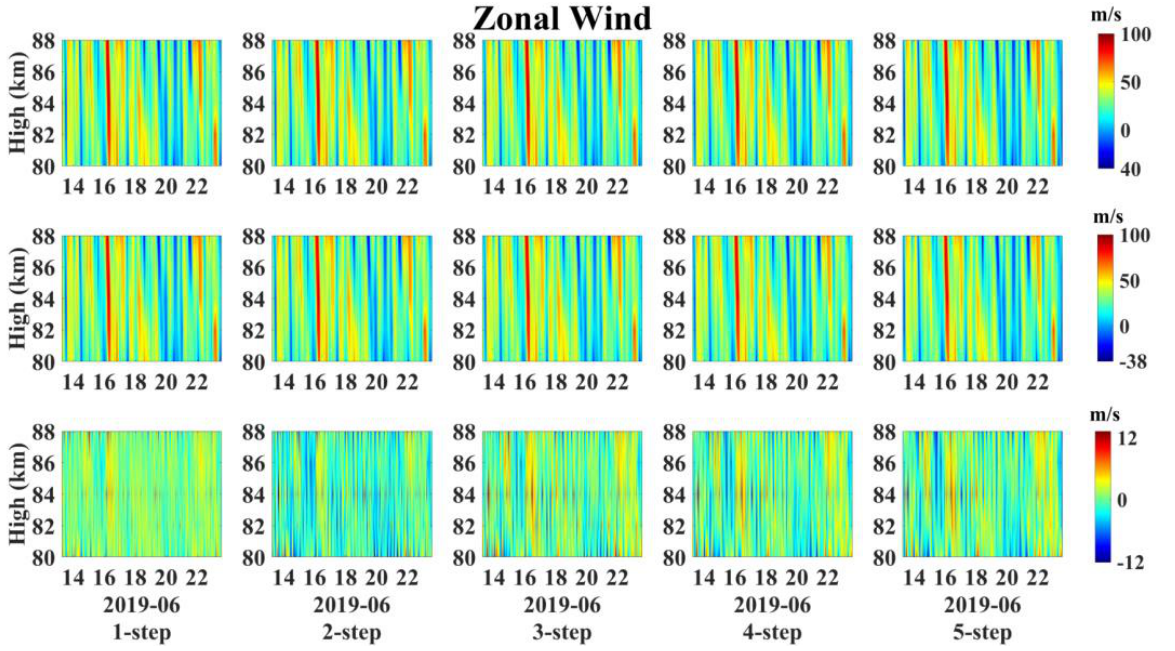
Figure 5. VMD – PSO – LSTM zonal wind 80 – 88 km prediction results from 14 – 23 June 2019. From top Figure 5. VMD–PSO–LSTM zonal wind 80–88 km prediction results from 14–23 June 2019. From top to bottom are observations, predicted value and absolute errors. to bottom are observations, predicted value and absolute errors.